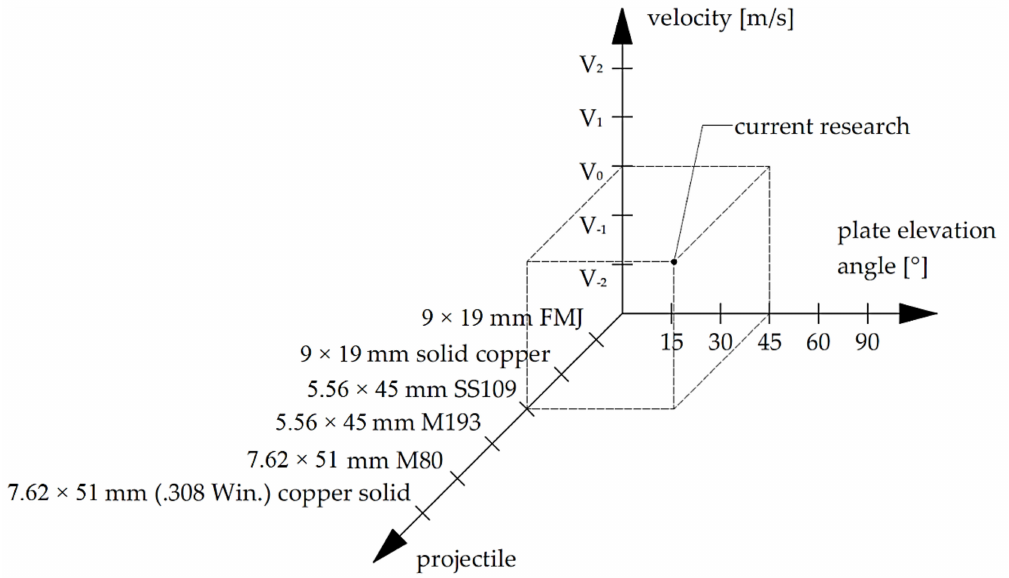
Figure 1. The scope of work to be performed in the project Arsonists (financing agreement number: